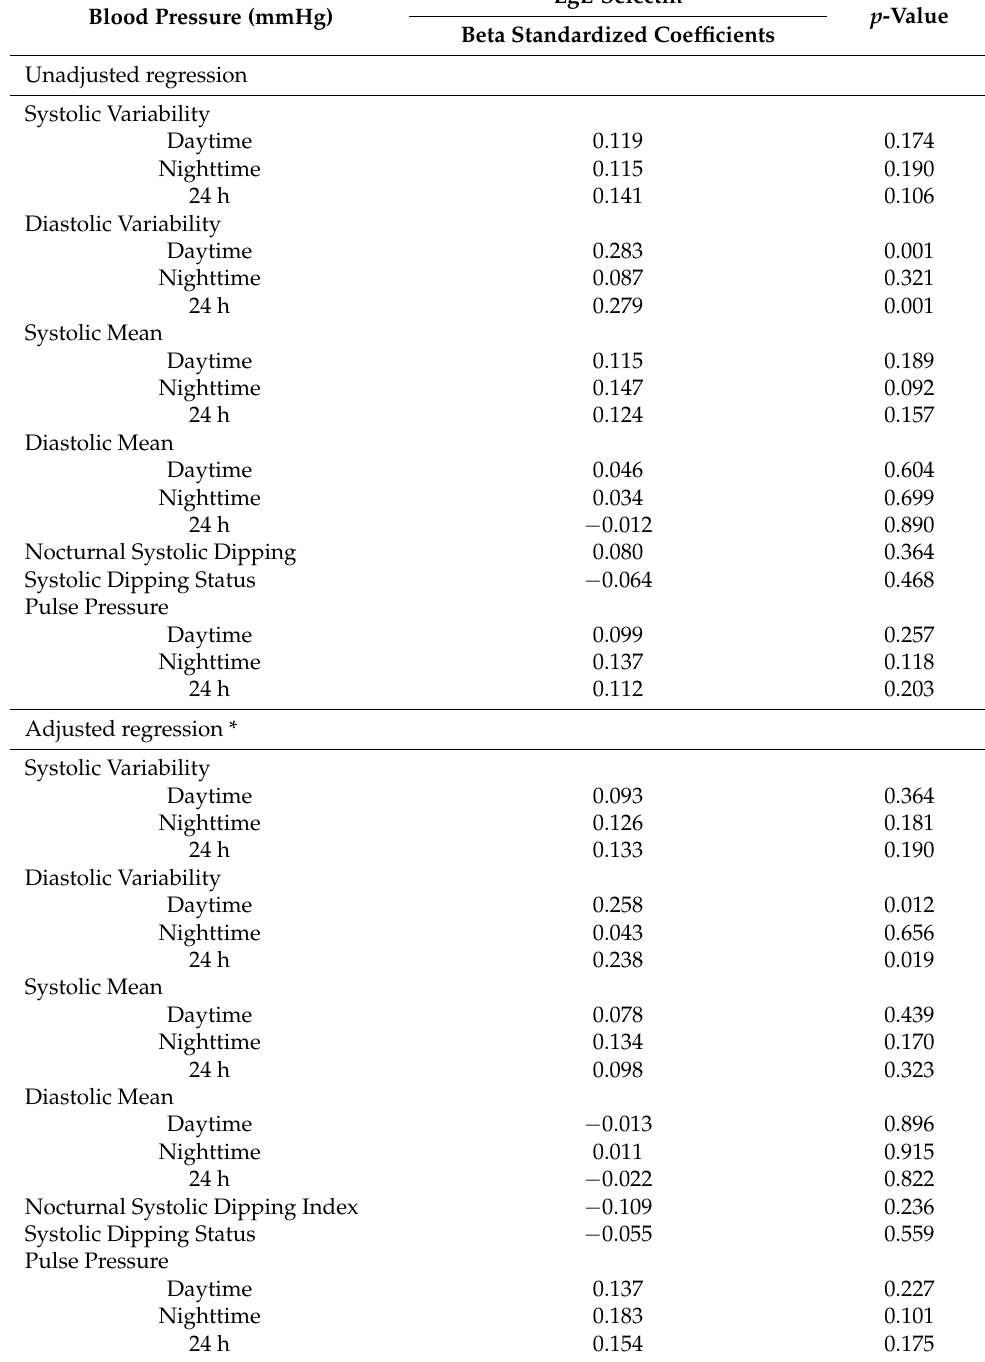
Table 4. Univariate linear regression analysis for the dependent variable lgE-Selectin using 24 h ambulatory blood pressure parameters as